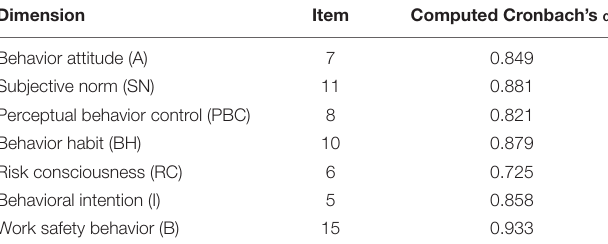
TABLE 4 | Reliability test of the scale involved in the model.